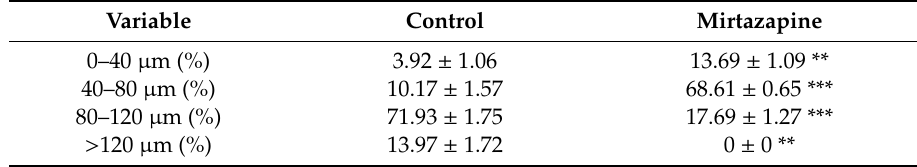
Figure 4. ( A ) Photomicrographs of H&E-stained liver and EWAT samples (magnification, 400×). Changes in ( B ) fatty liver scores and ( C ) adipocyte cellularity in the EWAT in the control and 10 mg/kg/day mirtazapine-treated mice over the 28 treatment days. We present all data in this figure as mean ± SEMs (n = 10) for both groups. ** p < 0.01, *** p < 0.001. Table 1. Changes in mirtazapine on fat cell size distribution of EWAT in the control and 10 mg/kg/day mirtazapine-treated high fat diet (HFD)-fed mice.